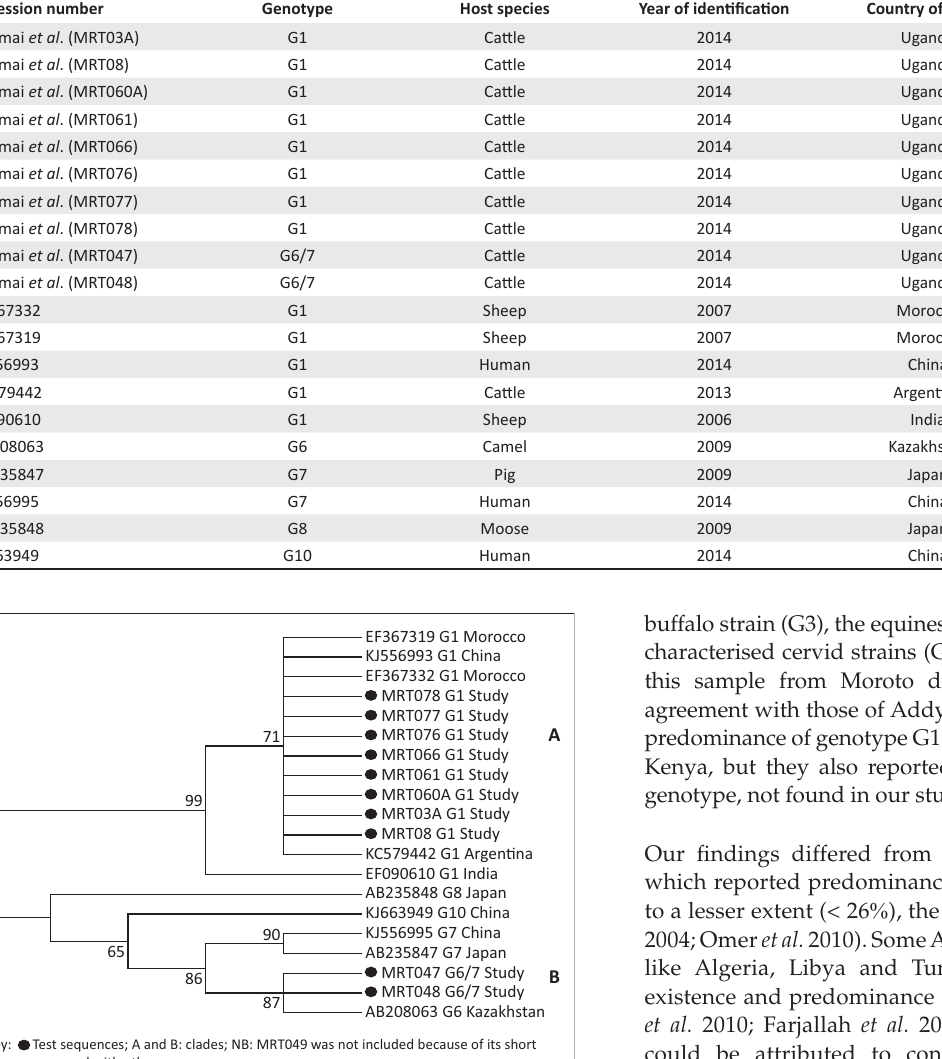
TABLE 3: Test sequences (MRT) and GenBank accession numbers for sequences used in phylogenetic tree construction. Accession number